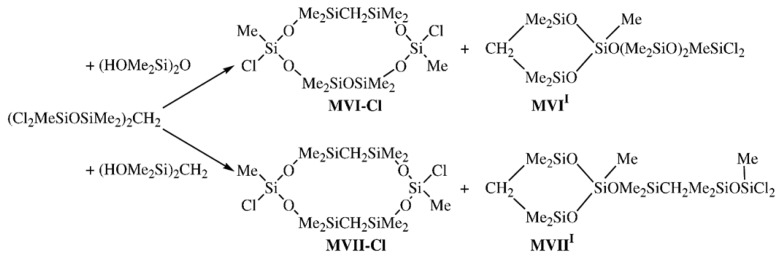
Synthesis of dichloromethylcyclocarbosiloxane structural isomers MVI-Cl, MVII and MII-Cl, MVIII.